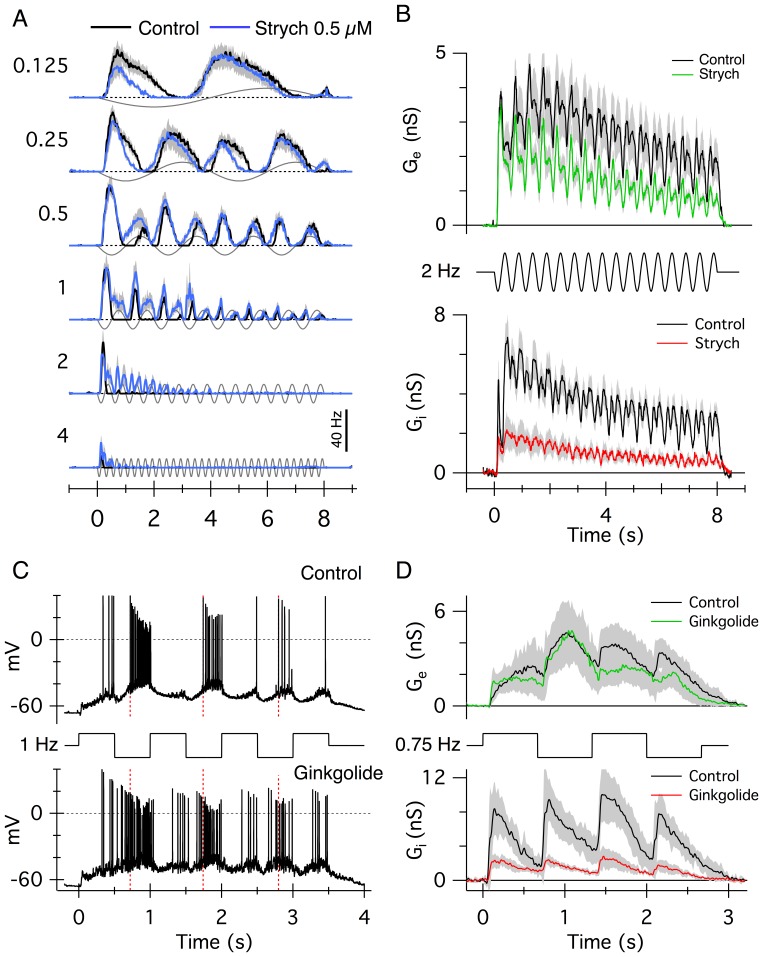
Glycinergic inputs limit the temporal responses of LEDs.(A) Average spike-time histograms generated from extracellular spike responses in 4 LEDs in control (black) and with 0.5 µM strychnine (blue). A significant increase in spiking is particularly evident at frequencies above 0.5 Hz (P<0.05). The stimulus was a 100 µm diameter spot that was sine-wave modulated from –80% to +80% contrast. The stimulus timing is shown in grey; the numbers adjacent to the records indicate the temporal frequency in Hz. (B) Upper panel: average light-evoked excitatory synaptic conductances calculated during 2 Hz stimulation with a small spot, in control (black) and with 0.5 µM strychnine (green). Lower panel: average inhibitory conductance Gi in control (black) and with 0.5 µM strychnine (red) during 2 Hz flicker stimulus. The timing of the 2 Hz stimulus timing is shown between the panels. Data averaged from 8 cells, shading shows the SEM. Suppression was not significant for excitation (P = 0.072), but was significant for inhibition (P = 0.0020). (C) Current clamp recordings made from an LED using a potassium-based intracellular solution (see Methods). The lower panel shows the same cell repatched with the addition of 1 mM ginkgolide to the internal solution. The stimulus was a 100 µm spot that was modulated at 1 Hz square wave flicker (timing shown between panels). The red vertical lines show the time of the first spike for the OFF phase of the stimulus in control. Note the shorter spike delay in the presence of ginkgolide (lower panel). (D) Average excitatory conductances (upper panel) and inhibitory conductances (lower panel) in control (black trace) and with 1 mM ginkgolide (colored traces) during 0.75 Hz square wave flicker. Average traces from two groups of 5 cells each are shown. The stimulus timing is shown between the panels. (n = 5, shading shows the standard deviation for each group of cells).